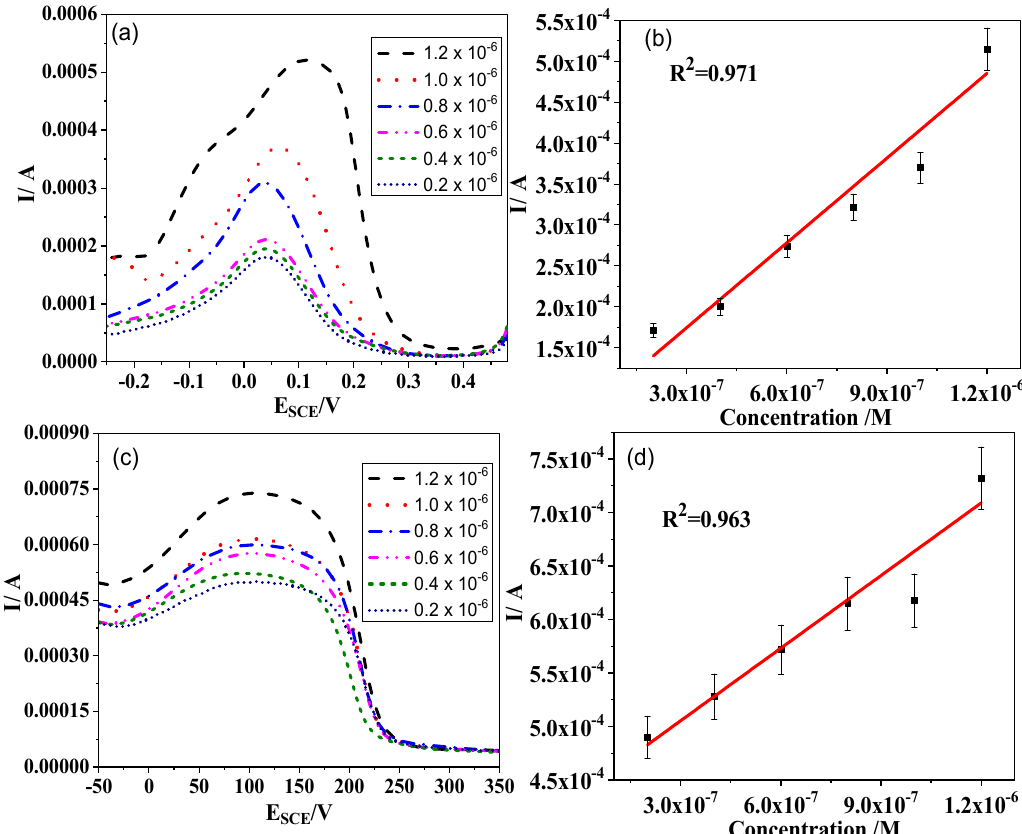
Figure 7. DPVs of ( a ) PACHA and ( c ) PANI at different H 2 O 2 concentrations; ( b ) and ( d ) display the current response of PACHA and PANI, respectively, with H 2 O 2 concentration ranging from 2 × 10 − 7 –1.2 × 10 − 6 M. Table 1. Comparison of various characteristics of PANI and PACHA along with the reported data.